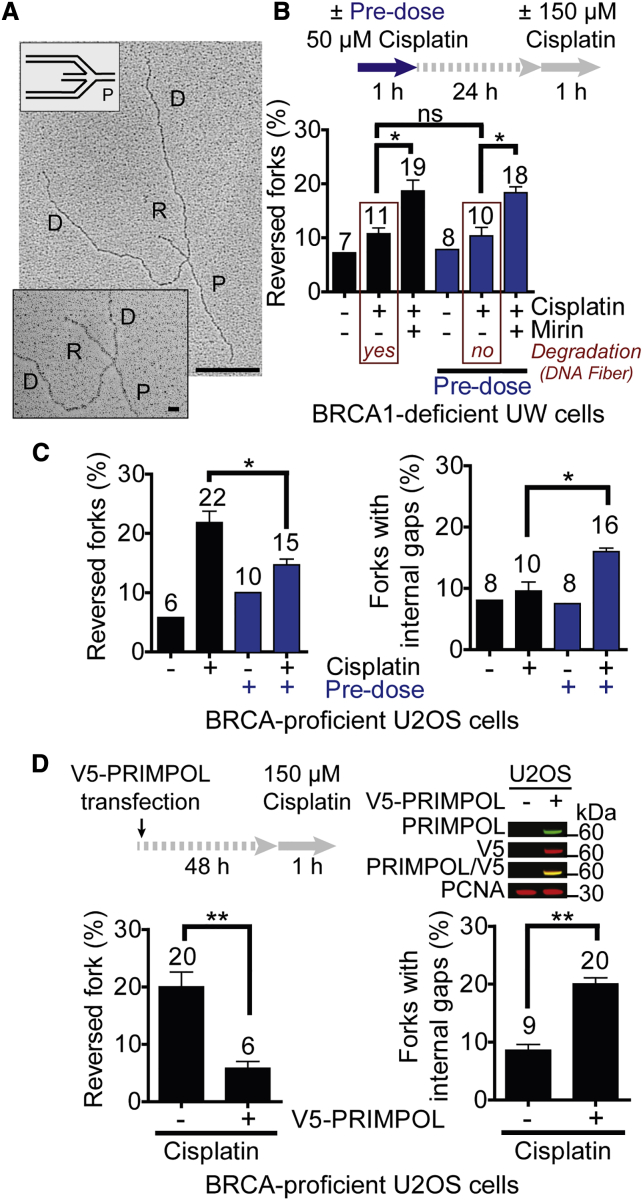
PRIMPOL Overexpression Is Linked to Decreased Fork Reversal(A) Representative electron micrograph of a reversed replication fork. Scale bar: 200 nm. Magnified four-way junction at the reversed fork. Scale bar: 20 nm. P, parental strand; D, daughter strand; R, reversed arm.(B) Schematic for the EM assay in UW cells treated with multiple doses of cisplatin (top). Percentage of reversed replication forks in UW cells ± 150 μM cisplatin ± pre-dose ± mirin. Means ± SEM (n = 3). Statistics: one-way ANOVA followed by Bonferroni test. (bottom). ns, non-significant, ∗p < 0.05.(C) Percentage of reversed forks (left) and forks with internal gaps (right) in U2OS cells treated with 150 μM cisplatin ± pre-dose. Average ± SEM (n = 3). ∗p < 0.05.(D) Schematic for the EM assay in U2OS cells overexpressing V5-PRIMPOL (top left). Expression of V5-PRIMPOL in U2OS cells (PRIMPOL in green, V5 in red, PRIMPOL/V5 shows simultaneous detection of both bands). PCNA was used a loading control (top right). Percentage of reversed forks (bottom left) and forks with internal gaps (bottom right) in U2OS mock-treated or overexpressing V5-PRIMPOL treated with 150 μM cisplatin. Means ± SEM (n = 3). Statistics: unpaired t test. ∗∗p < 0.01.See also Tables S1, S2, and S3.